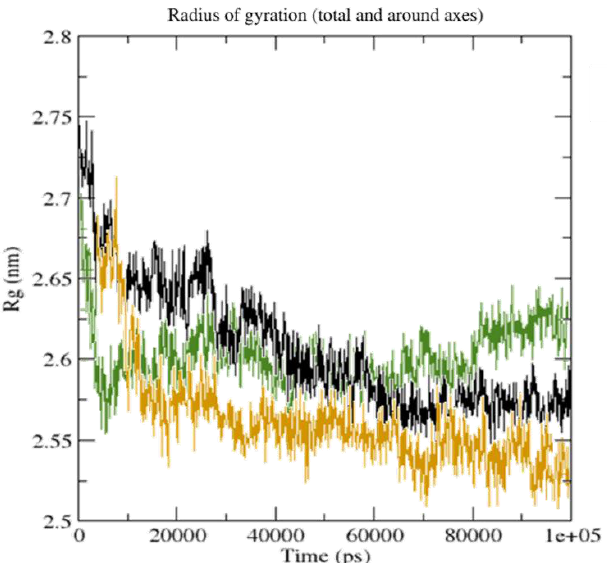
Figure 13. Radius of gyration of unbound serotonin alone (black), FXN–serotonin complex (green), and [(FXN)(PA)]–serotonin complex (brown) during 100 ns simulation.